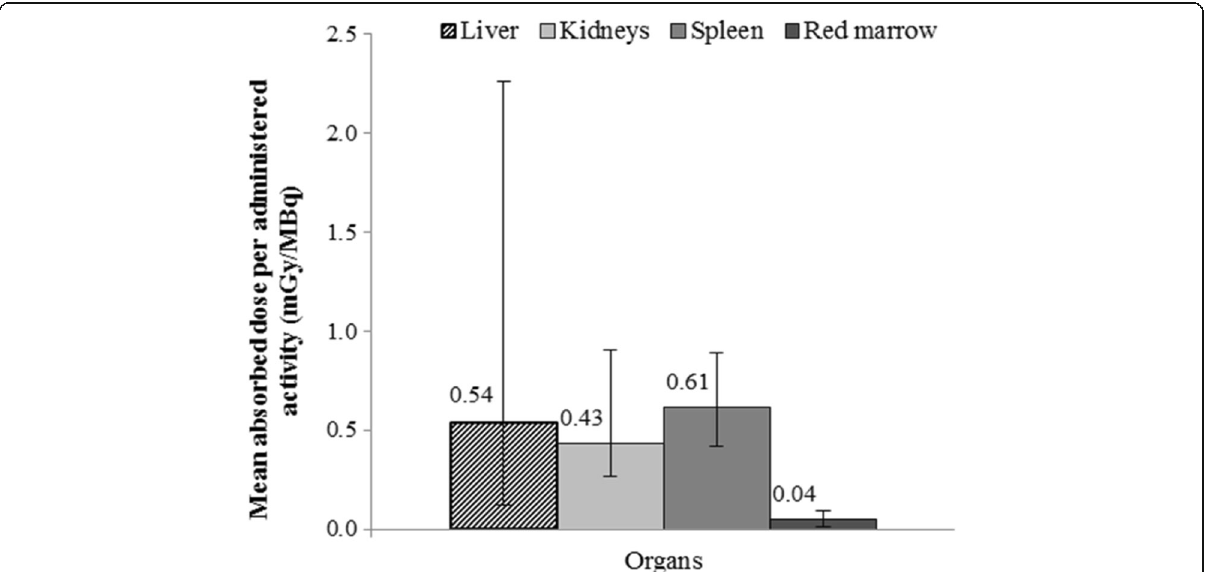
Fig. 6 Mean absorbed dose to organs per administered activity in mGy/MBq for all patients. The error bars show the range of the AD/A admin values for cycle 1 and